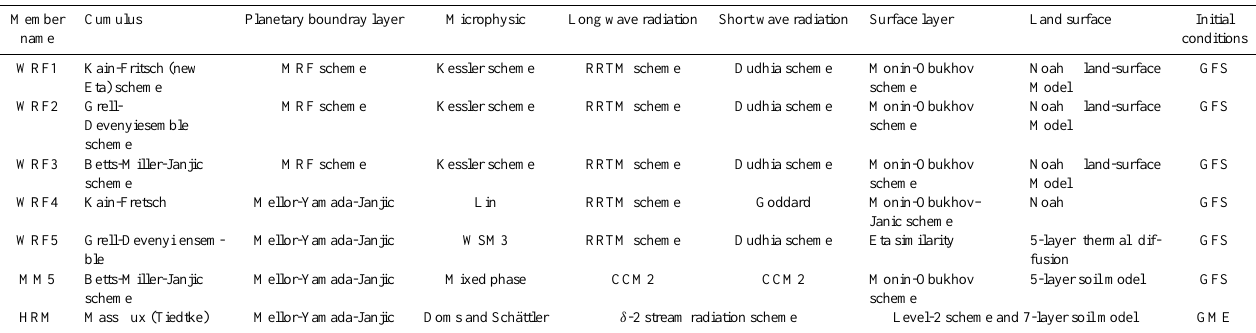
Table 1. Ensemble members